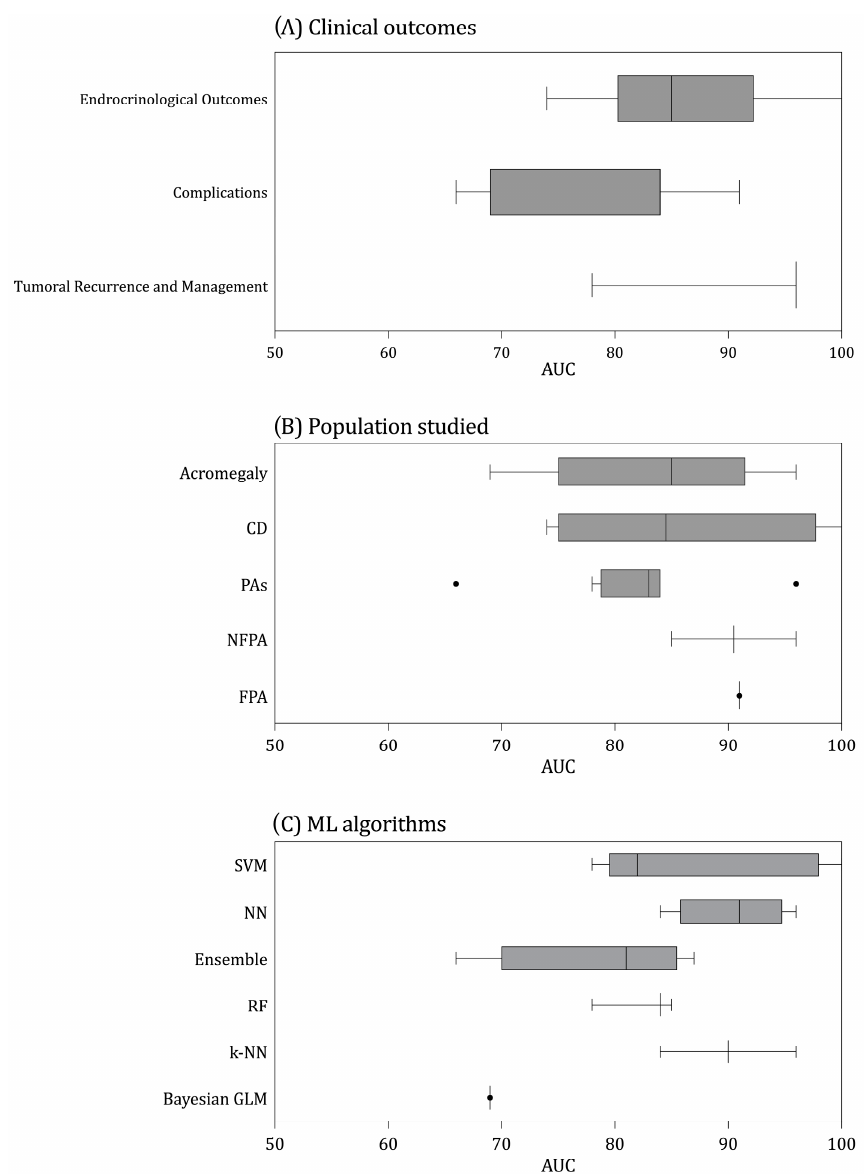
Figure 3. Box and whisker plots of AUC by categories of ( A ) clinical outcomes, ( B ) population studied, and ( C ) machine learning type of algorithm category. Center lines show the medians; box limits indicate the 25th and 75th percentiles; whiskers extend 1.5 times the interquartile range from the 25th and 75th percentiles, AUC values of each individual study are represented by dots. PA = Pitu- itary Adenoma; NFPA = Nonfunctioning Pituitary Adenoma; Functioning Pituitary Adenoma; CD = Cushing Disease; GLM = Generalized Linear Model; RF = Random Forest; SVM = Support Vector Machine; NN = Neural Network.